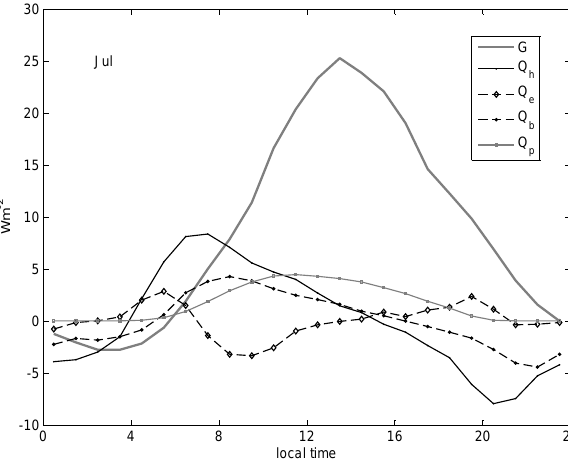
Fig. 5. Diurnal cycle of storage terms in July 2007: sensible heat ( Q h ), latent heat ( Q e ) and biomass ( Q b ) storage fluxes. and en- ergy consumed in photosyhthesis ( Q p ). The ground heat flux ( G ) is given for for reference. Note that storage terms are largest in June–August but still remain order of magnitude smaller than R n and turbulent fluxes shown in Fig. 4.